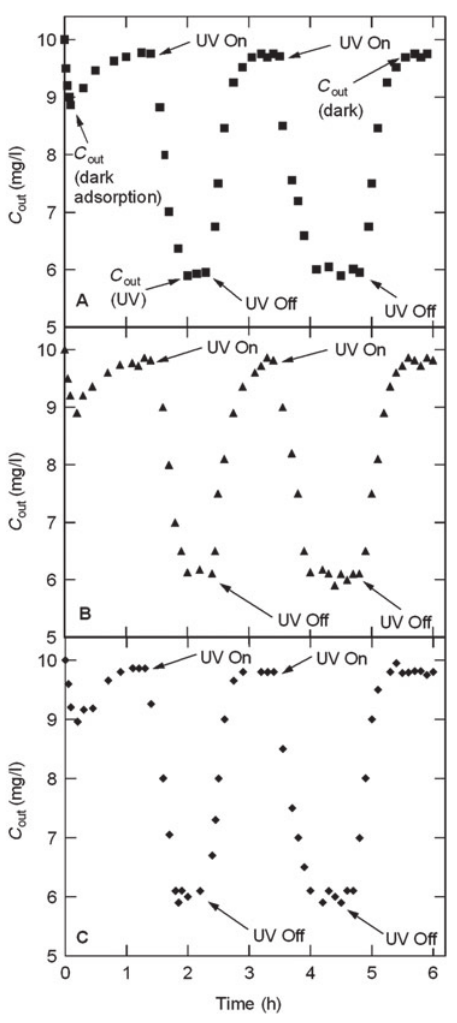
Figure 2 Dark-photocatalytic experiments. The system operates under continuous flow operation in transient regime for: (A) polyme- ric, (B) aluminum, and (C) polycarbonate microchannel reactors. At t = 0, the aqueous salicylic acid solution is introduced into the reactor in the absence of UV irradiation. At t = 1.4 h, a photocatalytic experi- ment is started by switching on the UV lamp ( “ UV On ” ). At t = 2.3 h, the irradiation is stopped ( “ UV Off ” ). Geometrical characteristics of the reactors: w = 1 mm, h = 0.5 mm, and L = 70 mm. Experimental = 10 mg/l, and I = 1.5 mW/cm 2 conditions: Q = 5 ml/h, C in